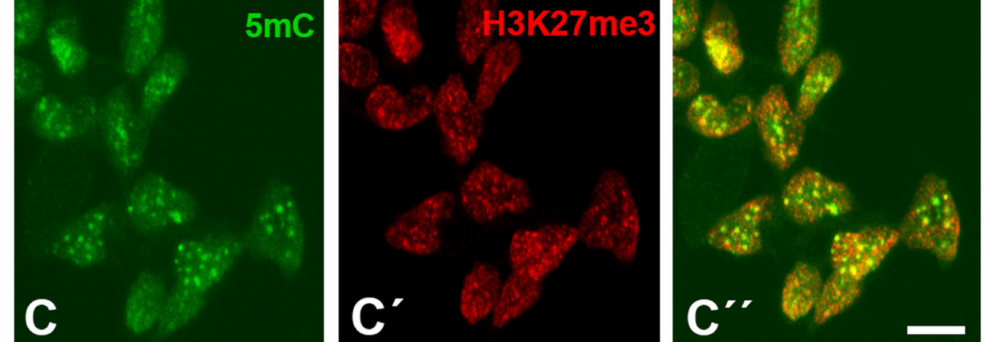
Figure 1. Immunolabeling of H3K4me3( A’ , A” ), H3K9me3 ( B’ , B” ), and H3K27me3 ( C’ , C” ) (red labeling) in combination with 5mC (green labeling, A , B , C ) in dissociated cells from the third interdigits of leg buds at id 6 (stage 29 HH). Note in the merged images ( A” , B” , C” ) that all three trimethylated histones show an dotted expression pattern overlapping with foci positive for 5mC ( A” , B” , C” ). Magnification bars = 5 µ m.